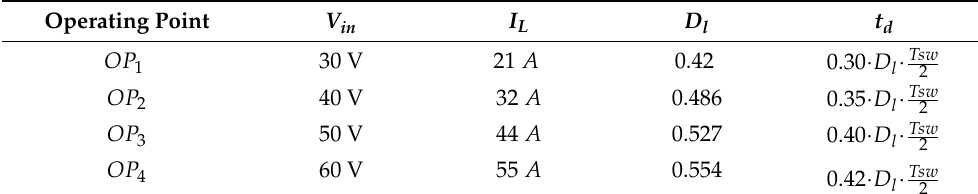
Table 1. Parameters to obtain the frequency response at different operating points.